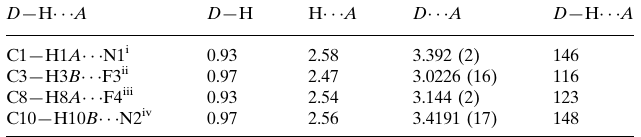
Hydrogen-bond geometry (A˚ , (cid:2)